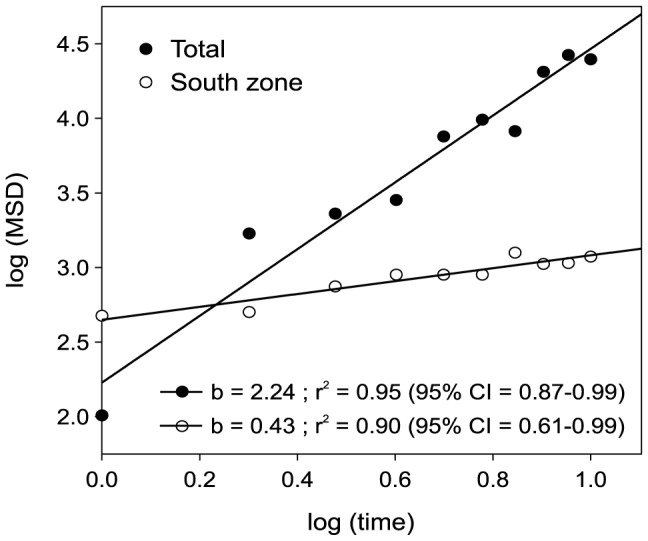
Patterns of Oculina patagonica dispersal.Mean square displacement (MSD) between the locations at which the coral species was found after the lag phase. The dispersal of the species during the exponential phase of spreading is provided separately for the overall distribution (Total) and for the southern zone (0 to 100 km coastal length). MSD is proportional to tα where t is time and α is the scaling exponent. 95% CI: 95% confidence interval calculated with bootstrapping.